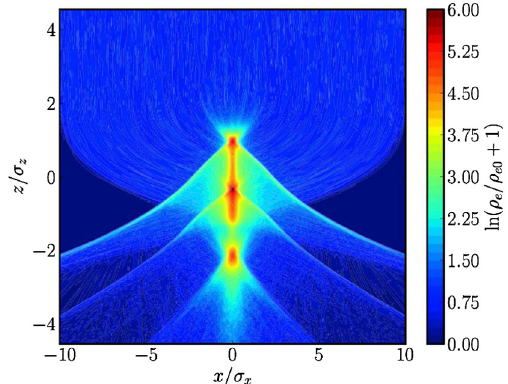
FIG. 2. Electron cloud density contour obtained from the tracking simulation for LHC parameters. The initial electron cloud charge density (cid:2) e normalize the color scale.